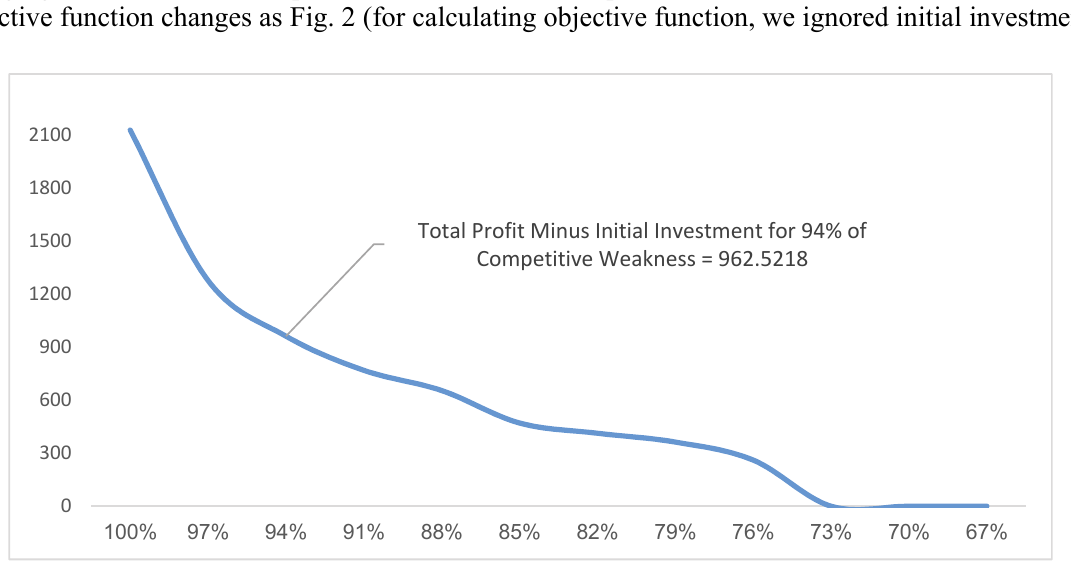
Fig. 2. Profit on stronger